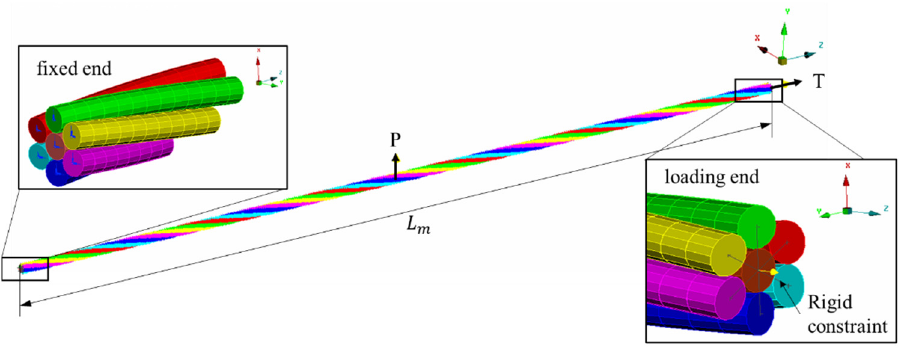
Figure 6. A complete quasi-static FE simulation model for simple strand with length of L m and loaded with T and P .